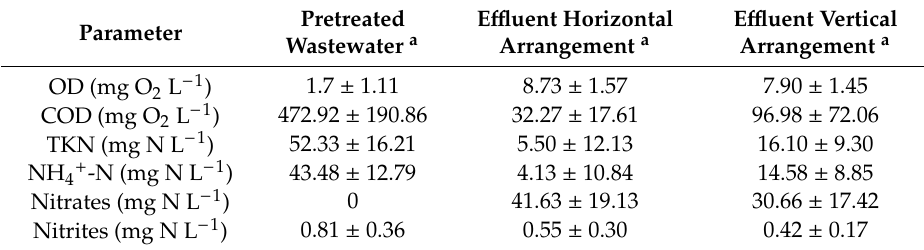
Table 1. Parameters measured for the pretreated wastewater and the e ffl uent of both pilot plants.